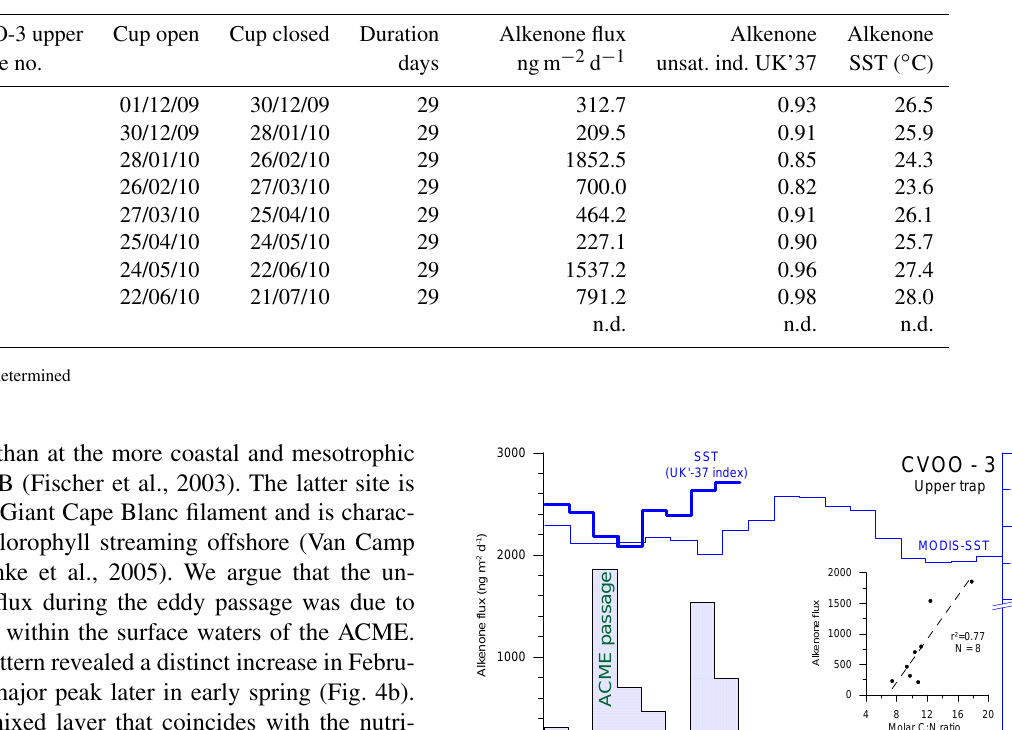
(cid:48) -unsaturation index and the estimated SSTs for samples 1–8 of the upper trap. 37